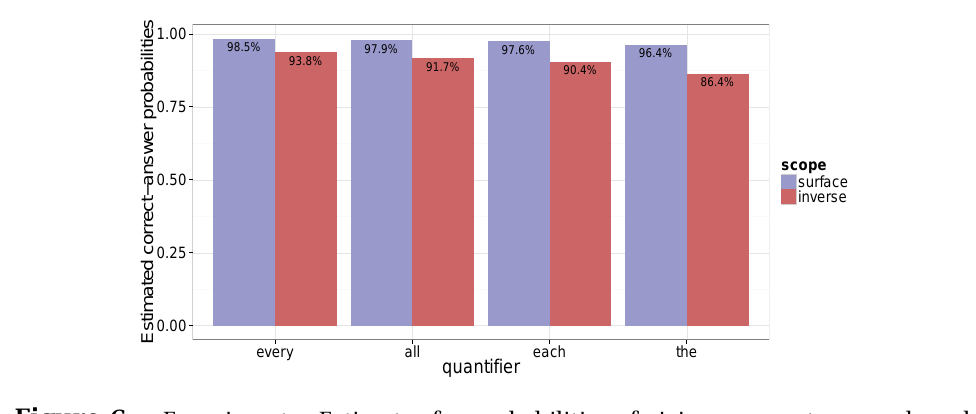
Experiment 1 : Estimates for probabilities of giving a correct answer based on the model in Table 4